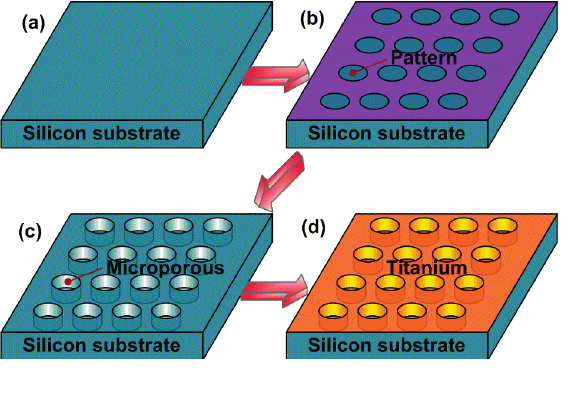
Figure 6. The manufacture process of the microporous surface by MEMS: ( a ) silicon substrate; ( b ) photolithography process; ( c ) deep reactive ion etching; ( d ) magnetron sputtering